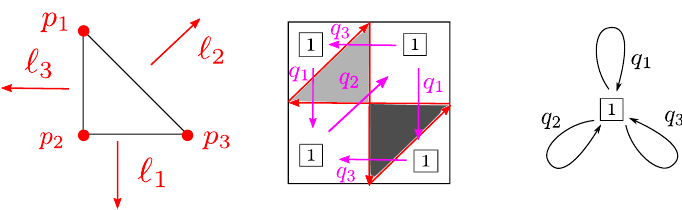
Figure 3. Toric diagram, periodic quiver, and quiver diagram of C 3 . The three lattice points of the toric diagram are denoted p The three external legs are denoted ‘